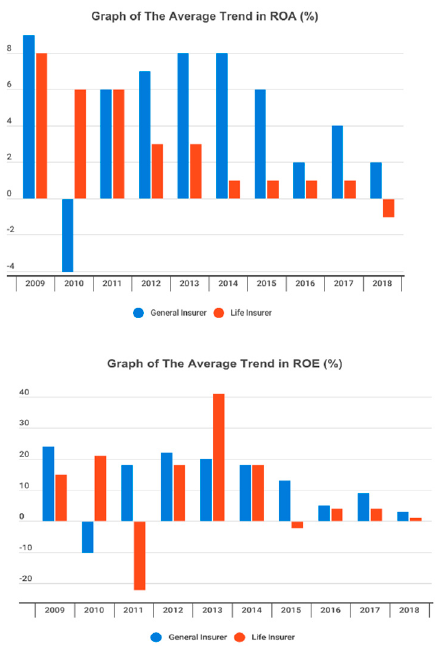
Figure 1. Trends in Return on Assets (ROA) for Both General and Life Insurers, 2009–2018.